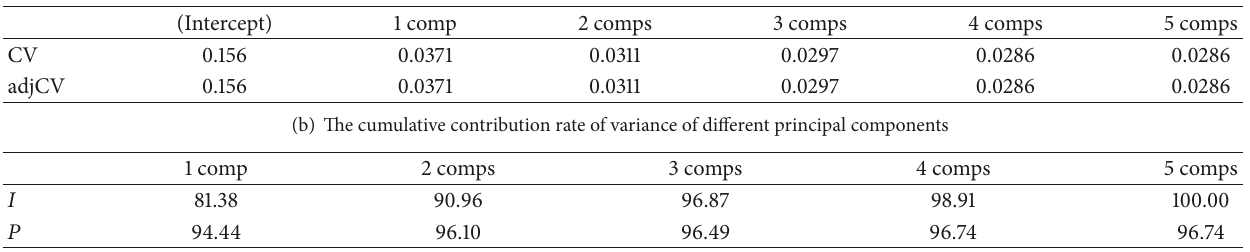
Table 2: Preliminary fitting results of PLS